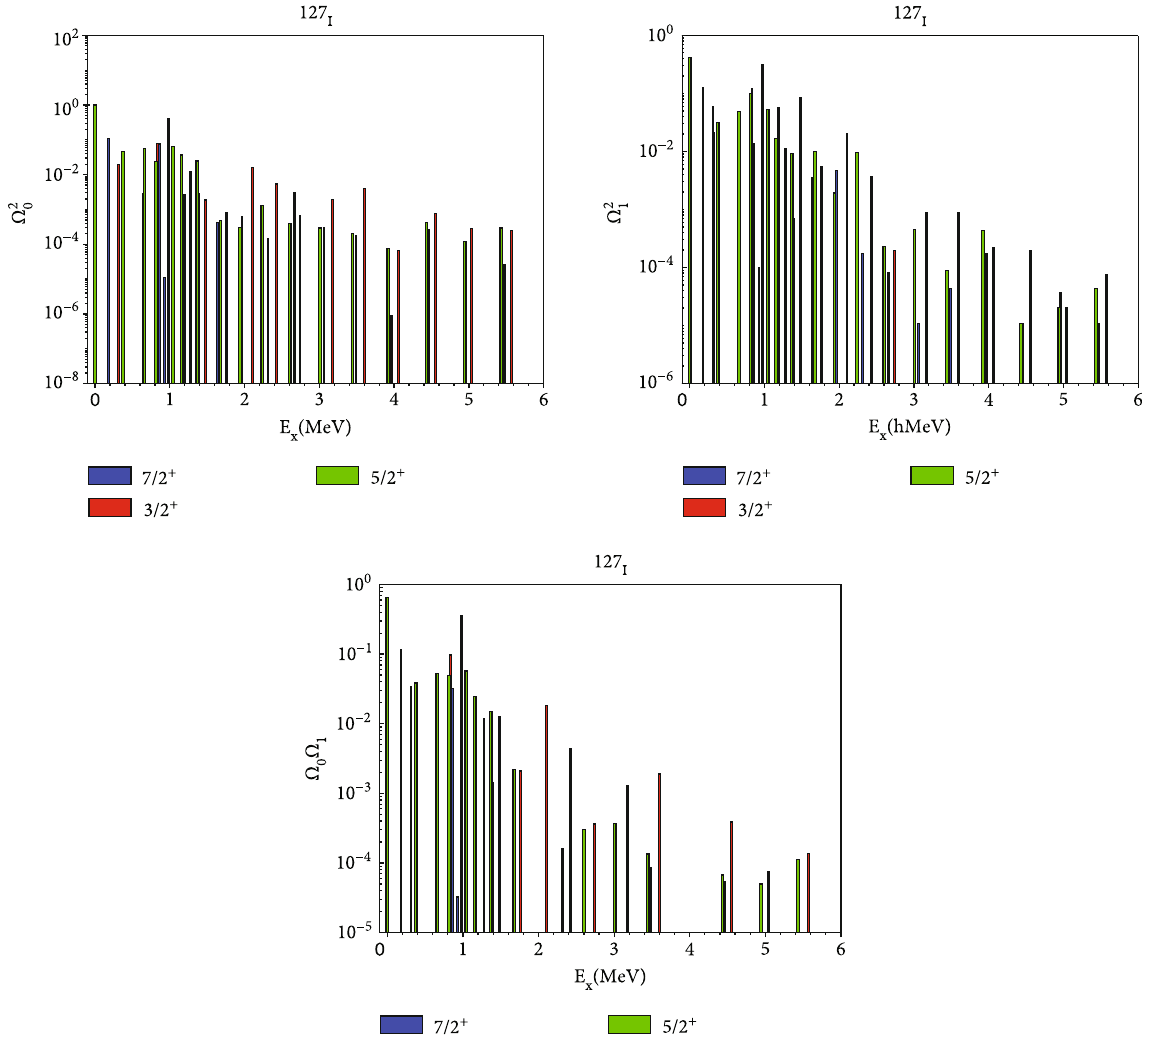
Figure 4: Isoscalar and isovector distribution of 127 I spin-reduced matrix elements from J should mention that the energy of the emitted photon is E γ = E